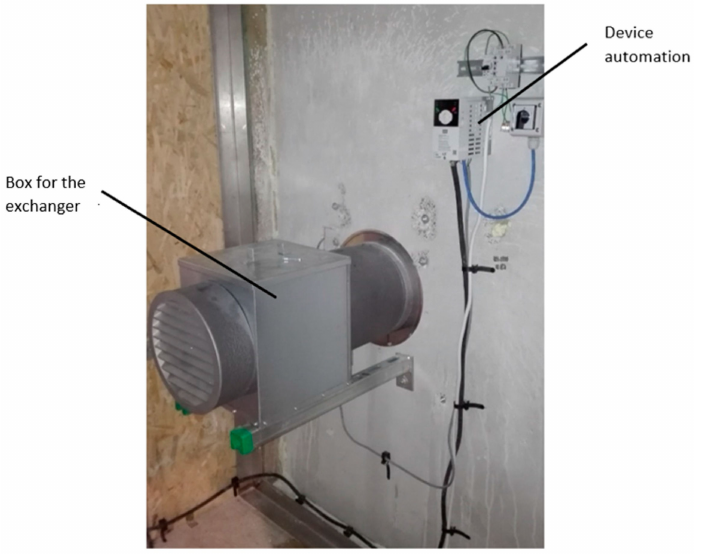
Figure 2. Façade ventilation unit (view from the side simulating indoor environment conditions).